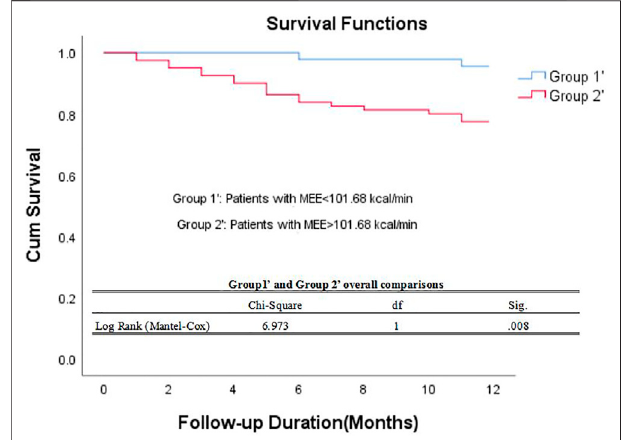
FIGURE 2 | ROC curve of MEE (cal/systole), MEE (Kcal/min), Valine (umol/l), Leucine (umol/l) and Free carnitine (umol/l).